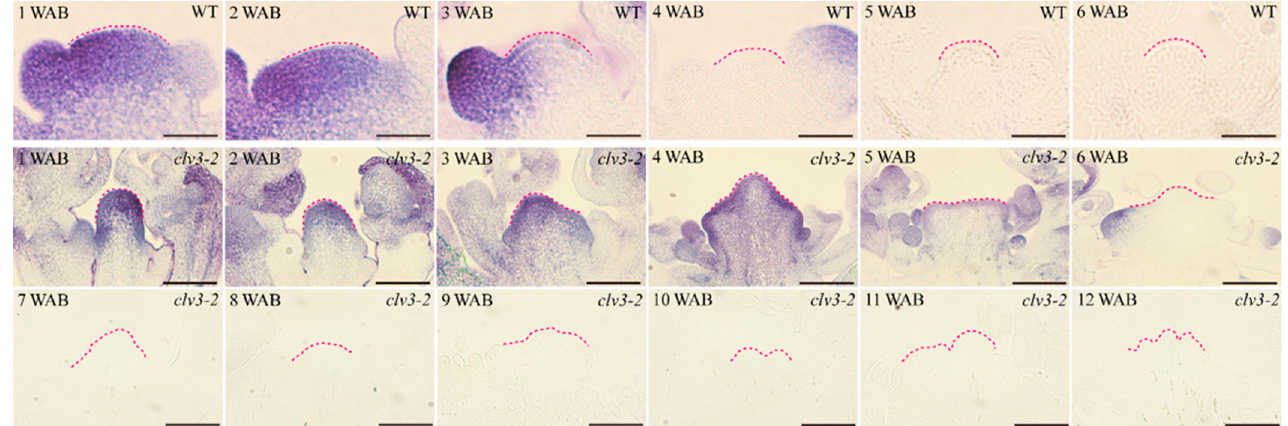
Figure 1. NBT staining of WT and clv3-2 IMs to demonstrate the O 2·- signals (blue color). Dotted pink lines indicate the IM shape. Scale bars: 25 μ m in WT and 100 μ m in clv3-2 . The spatial-temporal distribution of H 2 O 2 in the WT and clv3-2 IM domains was ob-